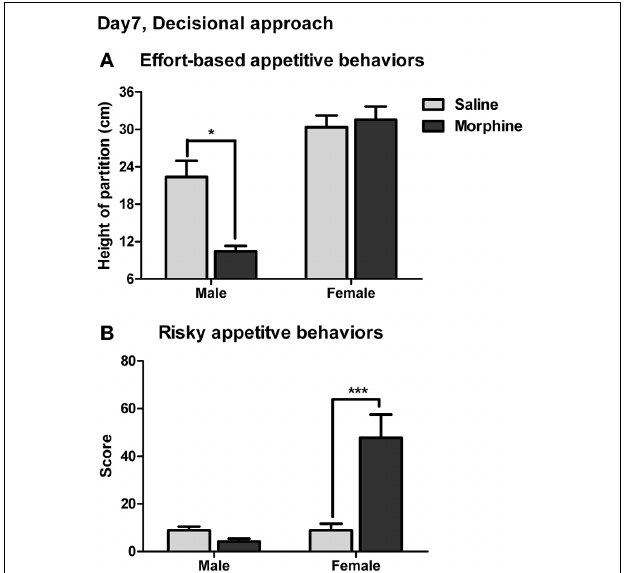
FIGURE 9 | The effects of morphine withdrawal on appetitive motivations for social or sexual reward in male rats under a restricted-approach condition (i.e., during the effort-based or risky appetitive behavior testing). The testing was performed on day 7 of withdrawal. (A) The maximum height of the partition that animals were willing to climb over to approach the stimulus-cage holding a male or estrous female rat. (B) The total score for the amounts of difficulty that animals were willing to conquer (i.e., climb over a continuously heightened board thick with pins) to approach the stimulus-cage holding a male or estrous female rat. ∗ P < 0 . 05, ∗∗∗ P < 0 . 001, relative to saline group. Values are mean ±